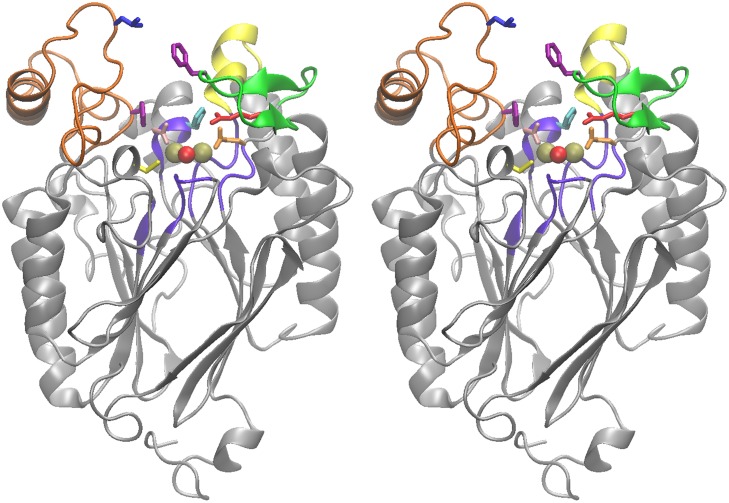
Stereogram of the model structure of human ADPRibase-Mn.Schematic model without substrate, showing metals (golden spheres), metal-bridging water (red sphere), the five short consensus regions of the MDP-superfamily motif (violet), and the ADPRibase-Mn unique regions s2s3 (green), h2 (yellow), and h7h8 (orange). The amino acids chosen for mutagenesis are highlighted and colored by residue: Gln27 (orange), Phe37 (magenta, in s2s3), Arg43 (red), Asn110 (pink), His111 (cyan), Leu196 (blue), Phe210 (magenta; in h7h8) and Cys253 (yellow). The model is based, as indicated in Materials and Methods, in the structure of the zebrafish homolog (PDB ID 2NXF).